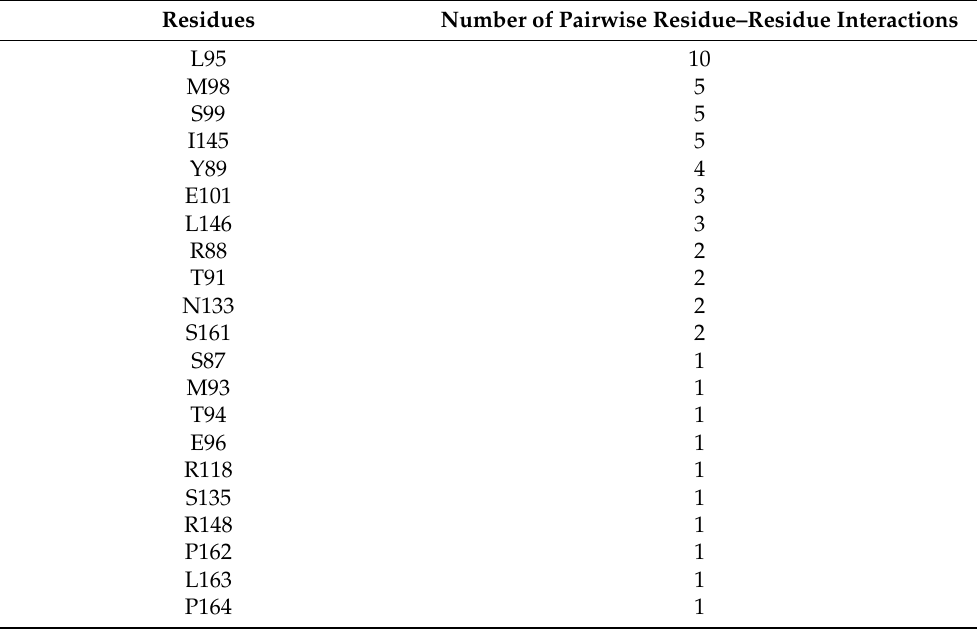
Table 7. NS1 residues participating in the most stable NS1-TRIM25 interfacial pairwise